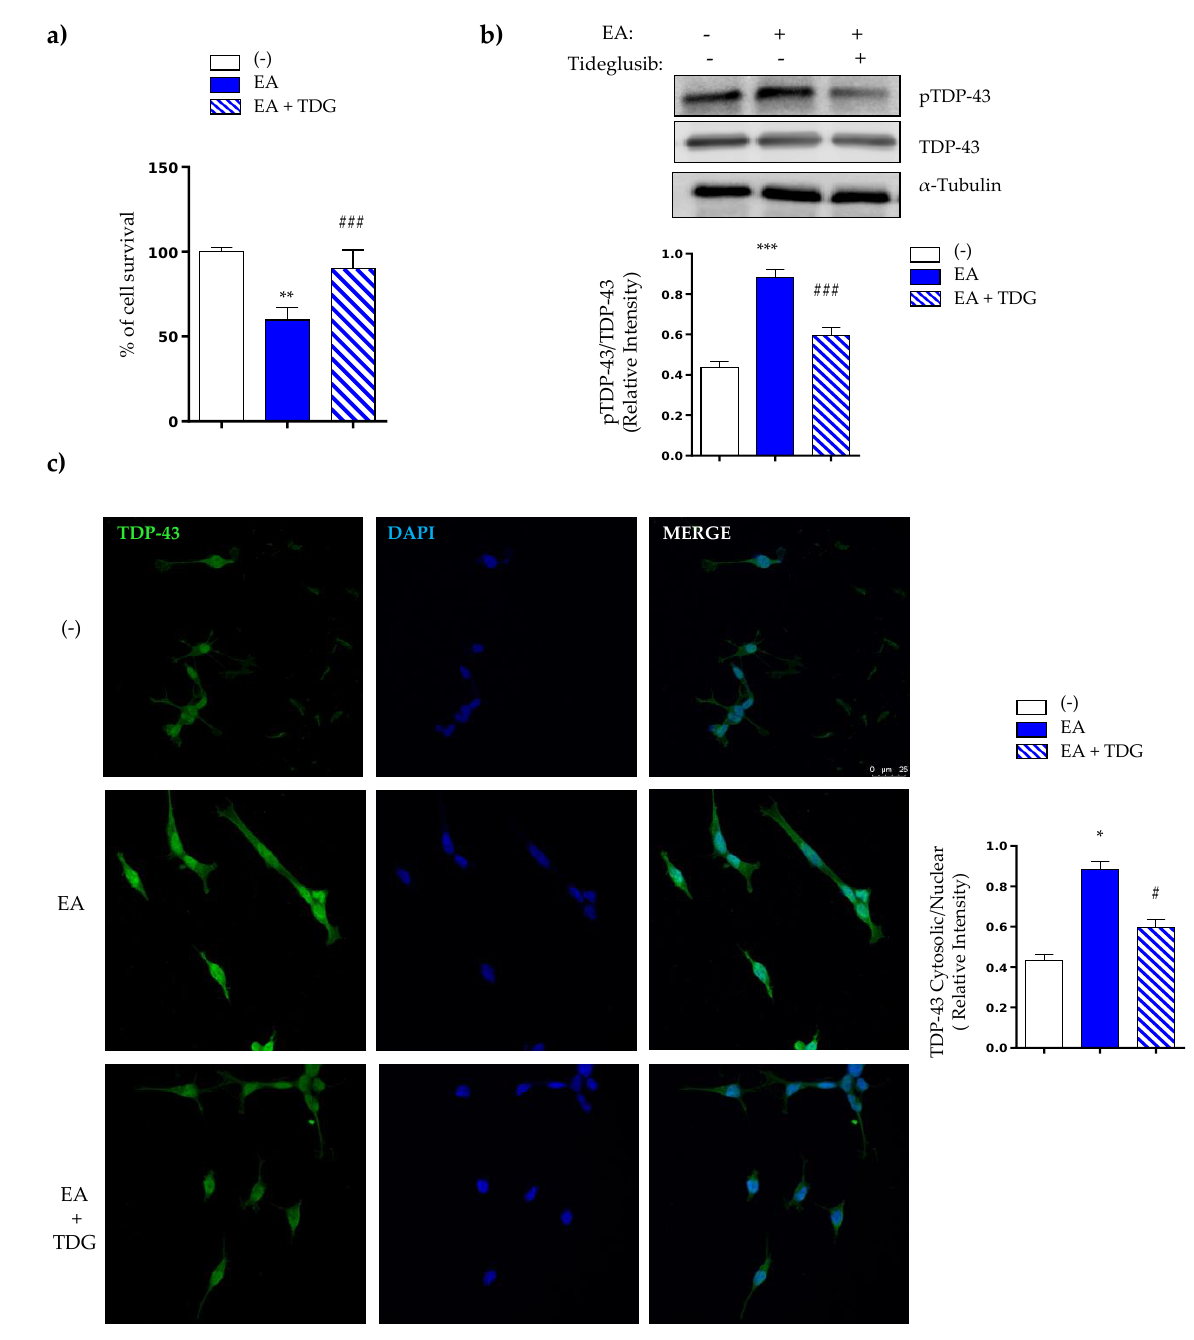
Figure 4. Neuroprotective effects of Tideglusib in ethacrynic acid pre-treated SH-SY5Y neuroblastoma cells. Neuroblastoma SH-SY5Y cells were exposed to 40 µ M EA for 12 h in the presence or in the absence of 5 µ M of Tideglusib (TDG). ( a ) Cell viability after drug treatments was measured by the MTT assay. ( b ) Representative immunoblot showing pTDP-43 protein levels before and after drug treatment. ( a , b ) Each data point represents the mean ± SEM of three replications in four different experiments (** p < 0.01 significantly different from SH-SY5Y untreated cells; ### p < 0.001 significantly different from EA-treated cells). The densitometric data represent the mean ± SEM of three different experiments (** p < 0.01, *** p < 0.001 significantly different from SH-SY5Y untreated cells; ### p < 0.001 significantly different from EA-treated cells). ( c ) TDP-43 protein localization was assessed by confocal laser scanning microscopy. Relative fluorescence intensity of TDP-43 staining inside and outside nuclei were determined on 30 different cells from four separate fields, in each condition. Values are the mean ± SEM. (* p < 0.05 significantly different from SH-SY5Y untreated cells, # p < 0.05 significantly different from EA-treated cells).